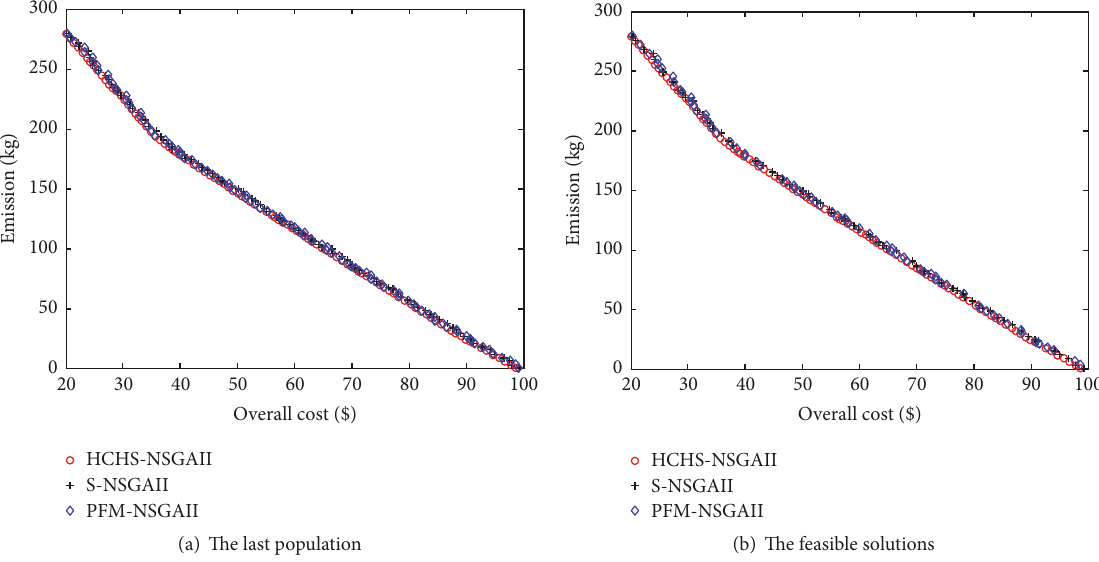
Figure 4: The best optimization results by HCHS-NSGAII, S-NSGAII, and PFM-NSGAII in Scenario One.